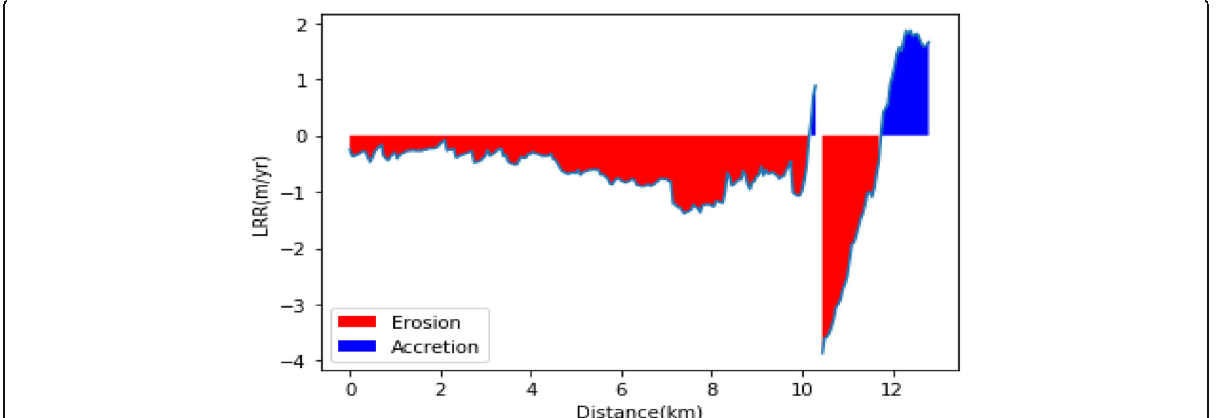
Fig. 7 Linear Regression Rate of Change along the marine side of estuary